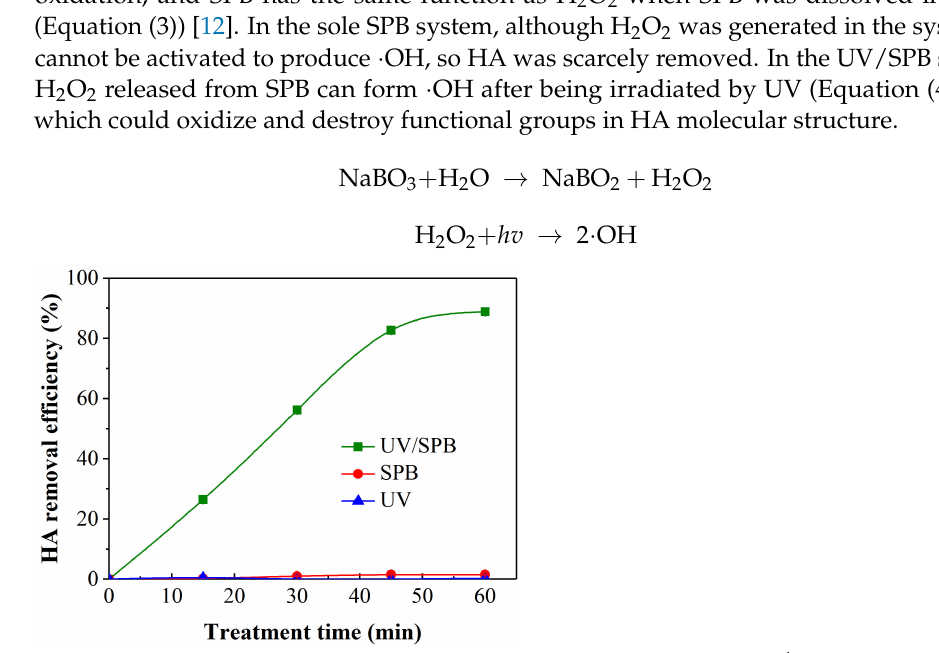
Figure 1. HA removal performance of different systems. [HA] 0 = 10 mg L − 1 , [SPB] 0 = 1 mmol L − 1 , pH =